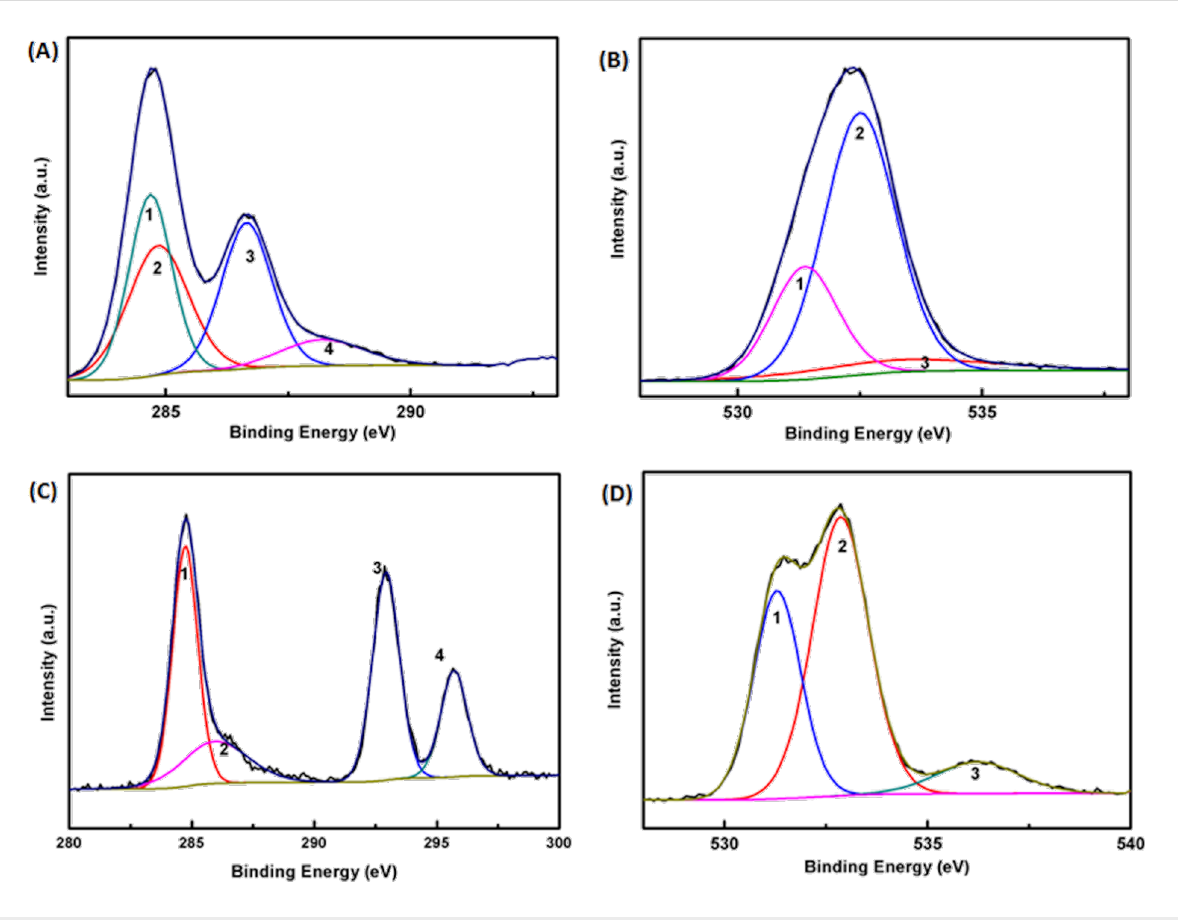
Figure 2: Deconvoluted XPS core-level spectrum of (A) C 1s, (B) O 1s for GO, (C) C 1s, and (D) O 1s for ERGO samples,